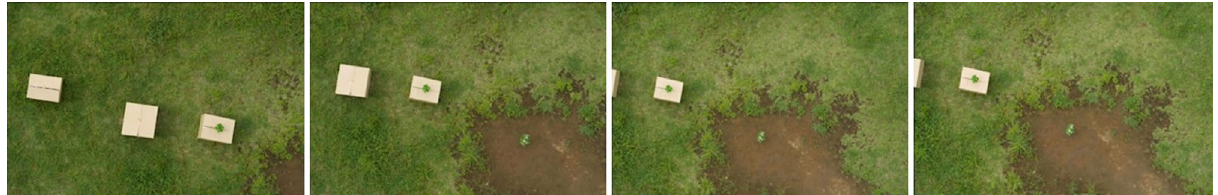
Figure 6. Example of a series of images.